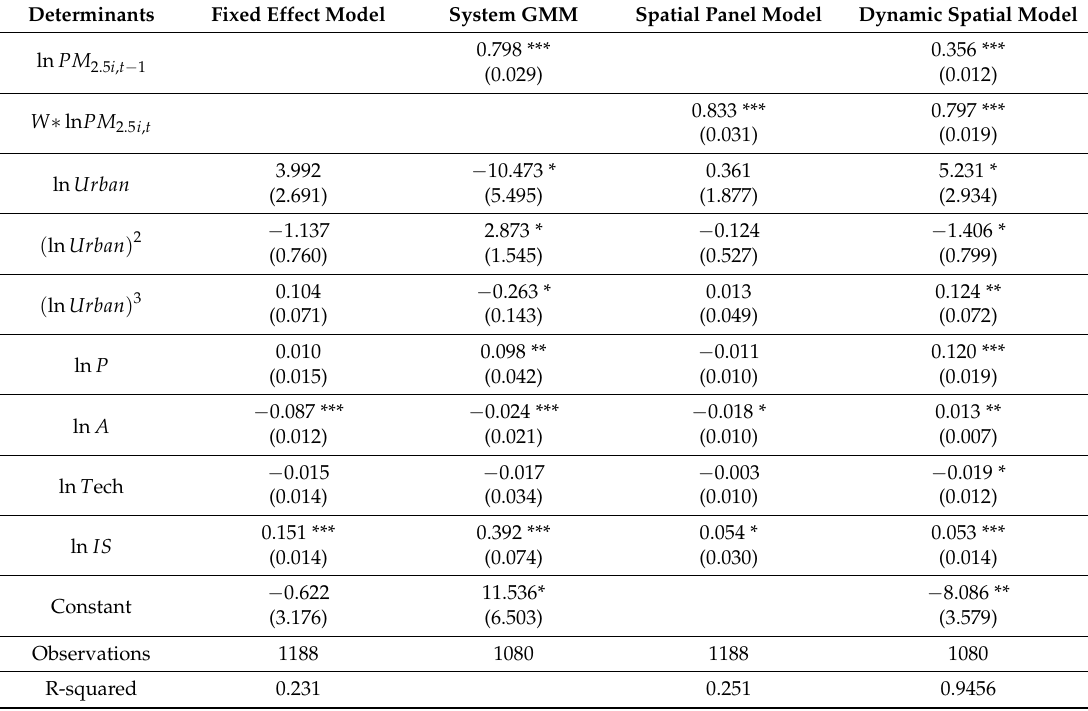
Table 3. Regression results of full